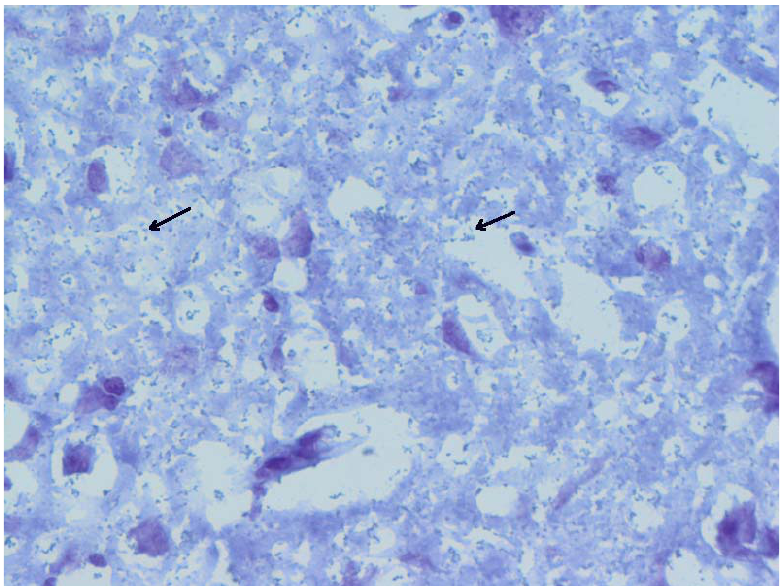
Figure 10. Detailed view of brain with mass of miniature cocci bacteria (tiny blue dots, black arrows pointing to examples) in animal No. 5. Gram staining, 40×.